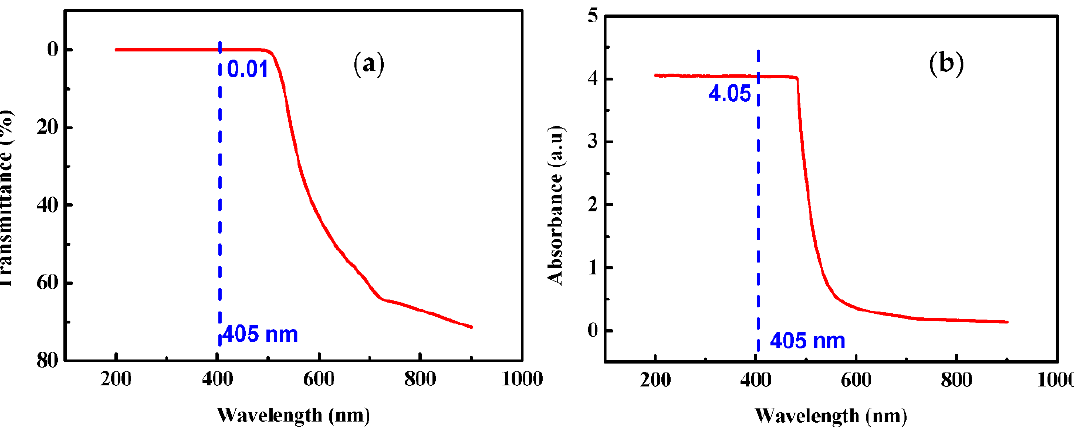
Figure 2. ( a ) Red solid line: transmission spectrum and ( b ) red solid line: absorption spectrum of pristine polyimide (blue dotted line in each curve shows the guidance to the transmission and absorption at 405 nm).